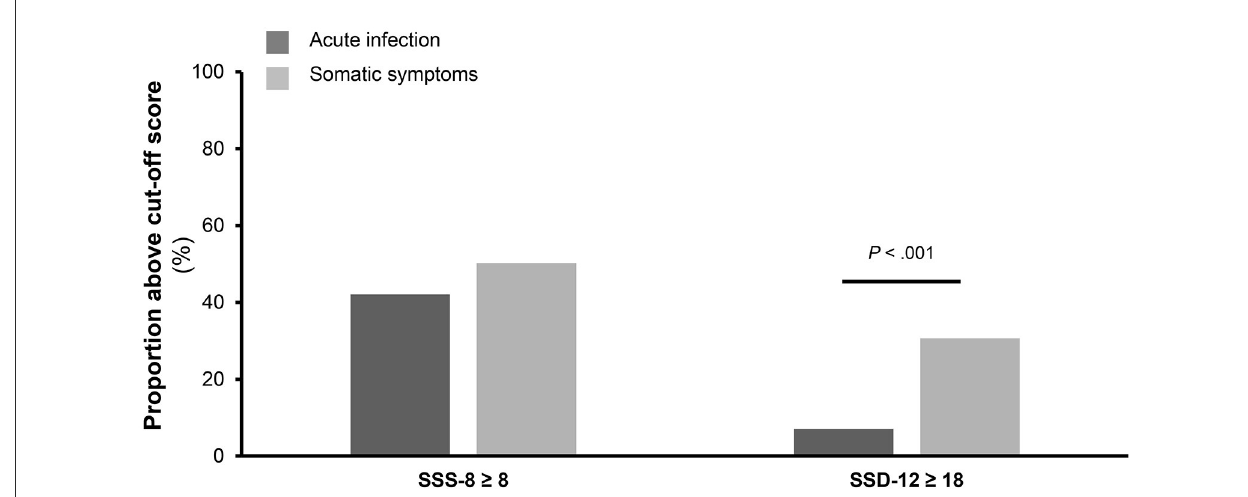
FIGURE4 Comparison of percentage of participants meeting the cutoff values. The figure shows the of percentage of participants meeting the cutoff values of the Somatic Symptom Scale-8 (SSS-8) and Somatic Symptom Disorder-12 (SSD-12) questionnaire stratified for participants of the acute infection group ( n = 140) and participants of the somatic symptom group ( n =